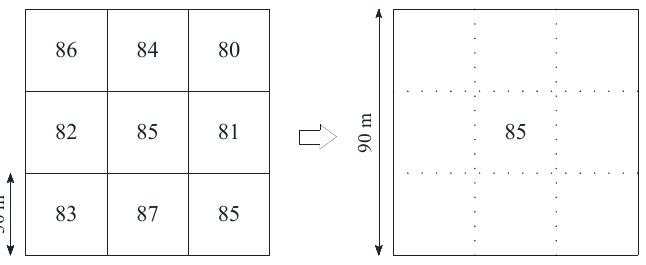
Figure 2. The nearest neighbor distribution method (numbers represent elevation values).